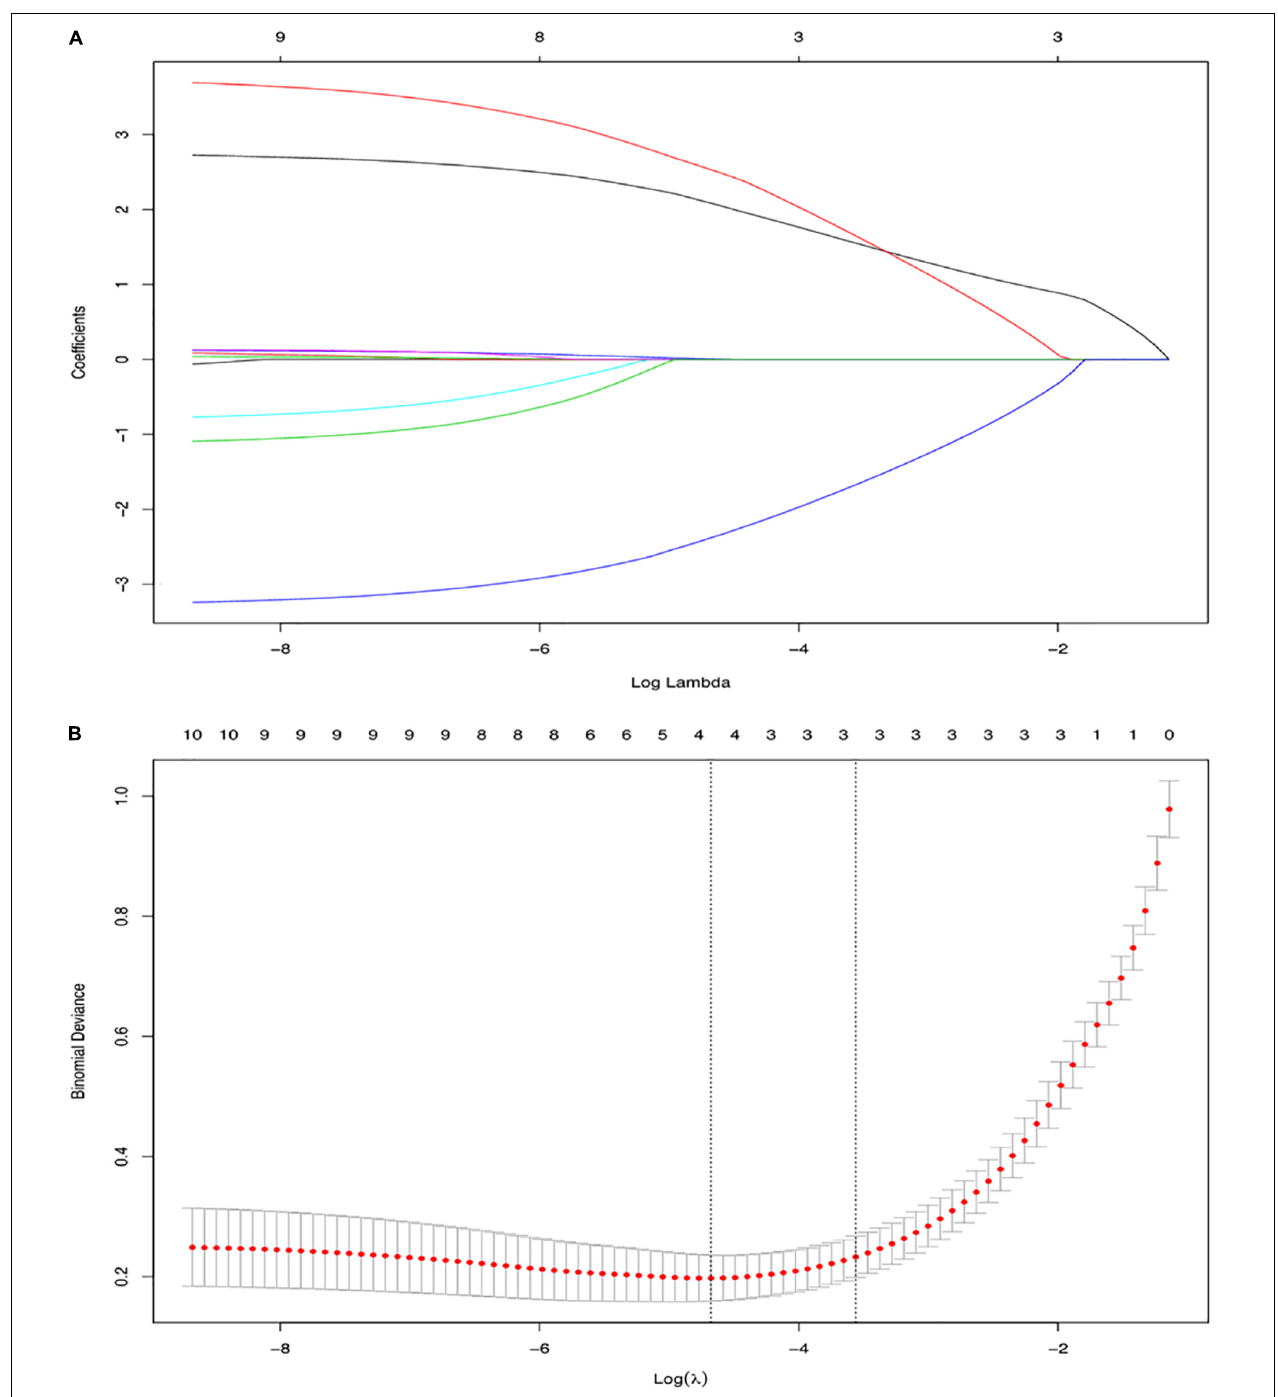
FIGURE 1 | Variable selection using the least absolute shrinkage and selection operator (LASSO) binary logistic regression model. (A) LASSO coefficient profiles, displaying 11 variables. A coefficient profile plot was produced against the log (lambda) sequence. Each colored line represents the coefficient of an individual feature. (B) Tuning parameter (log lambda) selection in the LASSO model used tenfold cross-validation via minimum criteria. Vertical dotted lines were drawn at the selected λ values. LASSO, Least Absolute Shrinkage and Selection Operator.